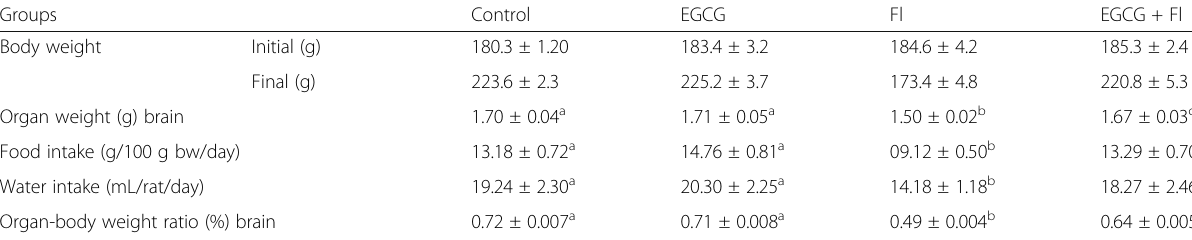
Table 3 Changes in body weight, body weight gain, food intake, water intake, and organ-body weight ratio in control and experimental rats Groups